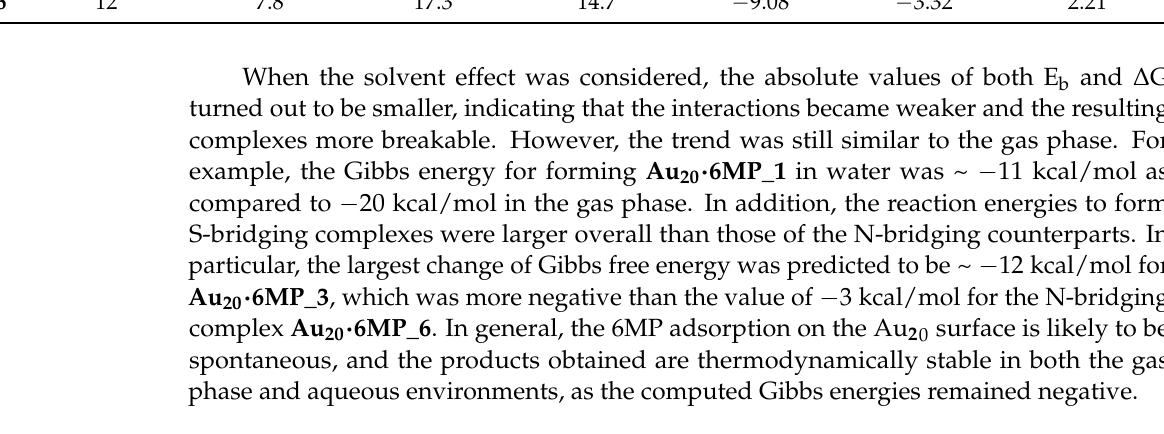
Table 1. Relative energy (RE), binding energy (E b and Gibbs energy ∆ G 298 in kcal/mol for the 6MP adsorption on A u20 , along with Au − X=S, N) bond lengths in the resulting complexes (PBE/cc-pVTZ/cc-pVDZ-PP + ZPE). RE E b ∆ G 298 Complex In a Vacuum In Water In a Vacuum In Water In a Vacuum In Water Au 20 · 6MP_1 0.0 0.0 29.4 Au 20 ·